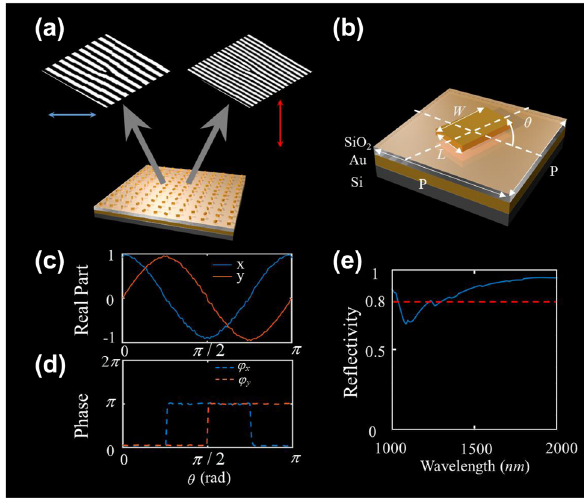
Figure 2: Design of the metasurface-based (de)multiplexer. (a) Two Dammann vortex grating phases with different periods are integrated on the same metasurface with x - and y -polarization. (b) Geometric parameters of a metaatom. (c) and (d) The real part and phase of x - and y -polarized components of output field for different orientation angles 𝜃 . (e) The reflection efficiency from 1000 nm to 2000